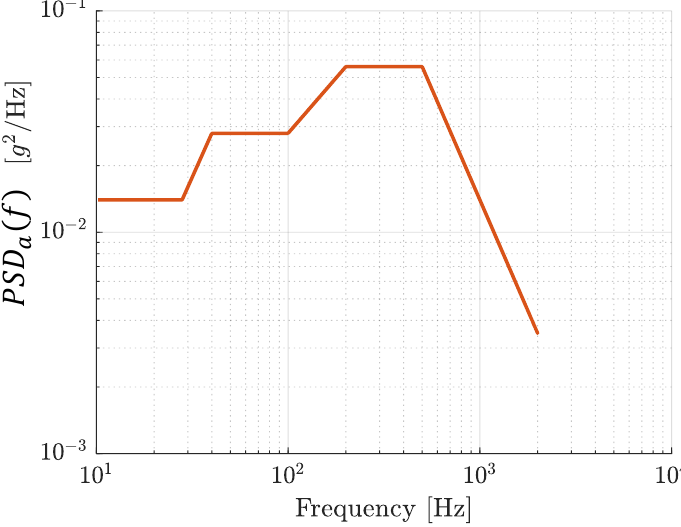
Figure 4. PSD of the acceleration of the external support of the slat. The piezoelectric patch is very thin and flexible and covers a very small part of the whole slat. Therefore, the vibrations of the slat caused by the motion of the supports are not influenced by the presence of the patch. Conversely, the deformation of the portion of the slat skin where the patch is attached determines the strain inside the PE patch and the generated voltage. The adhesive and protective layers that are inserted between the slat skin and the PE patch may also influence the generated voltage. For the above-mentioned reasons, a computational method based on the synergic use of a large-scale model and a small-scale model was developed. Figure 5 shows a flow chart that describes the steps and the interactions between the large-scale and small-scale models.